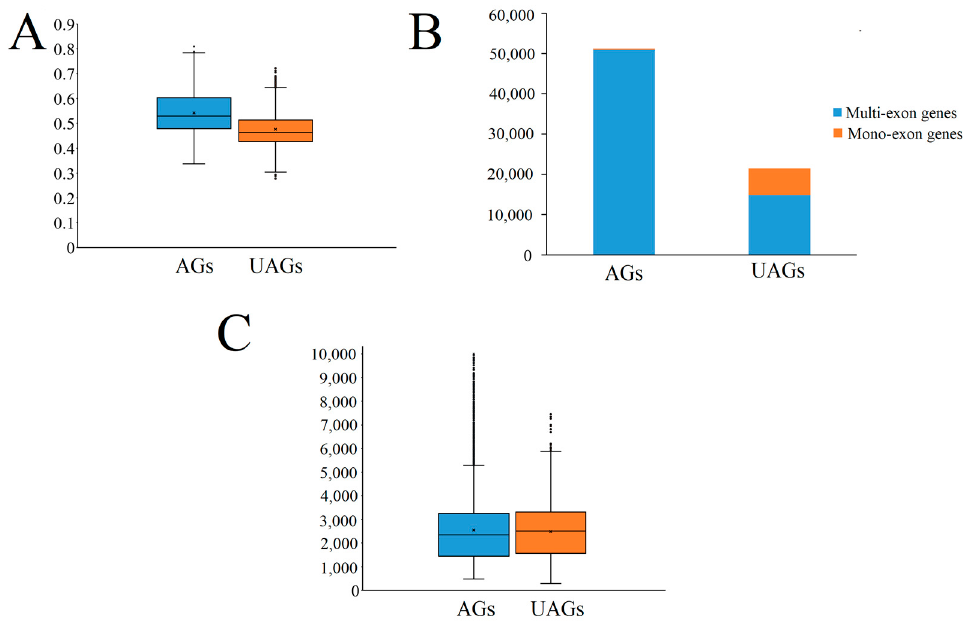
Figure 2. Comparison of the novel genes identified by isoform sequencing and previous annotated genes. ( A ) Distribution of GC content among the AGs and UAGs. ( B ) Comparison of gene numbers of mono-exon and multi-exon genes among AGs and UAGs. ( C ) Comparison of mRNA length between AGs and UAGs.